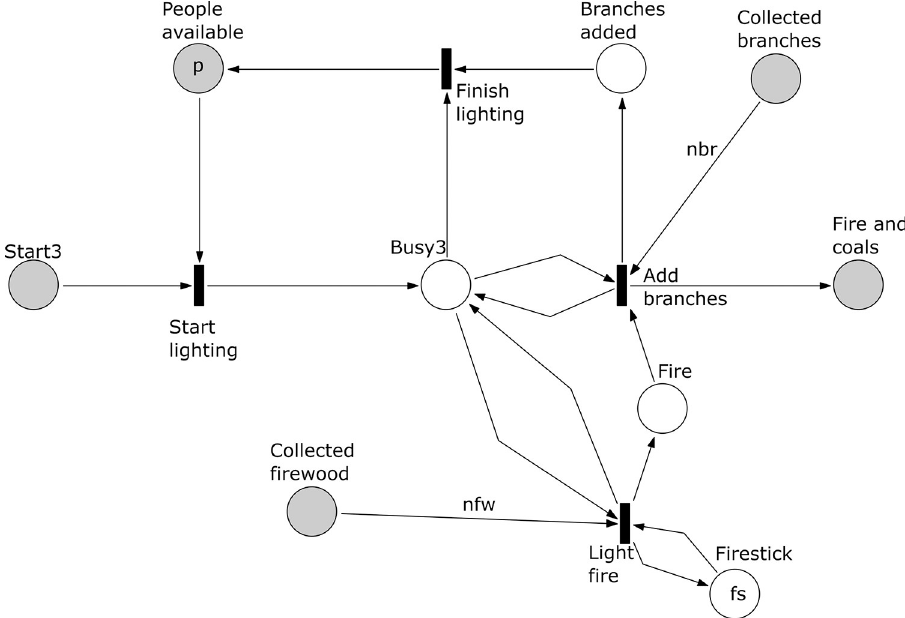
Fig 5. Subprocess 3 Light Fire of the A . coranica model.